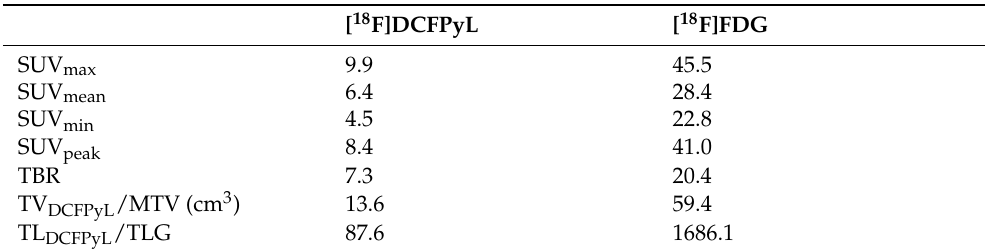
Figure 4. Maximum Intensity Projection (MIP) PET images of all included patients. The arrows indicate the location of the primary tumor. In the MIP PET images with an asterisk the primary tumor was not visible. [ 18 F]FDG PET/CT of patient 5 was not performed as this was not the standard of care due to his cT2-3 gastric tumor. Patient numbers are identical to Table 1. Table 2. Overview of extended imaging parameters of patient 1.